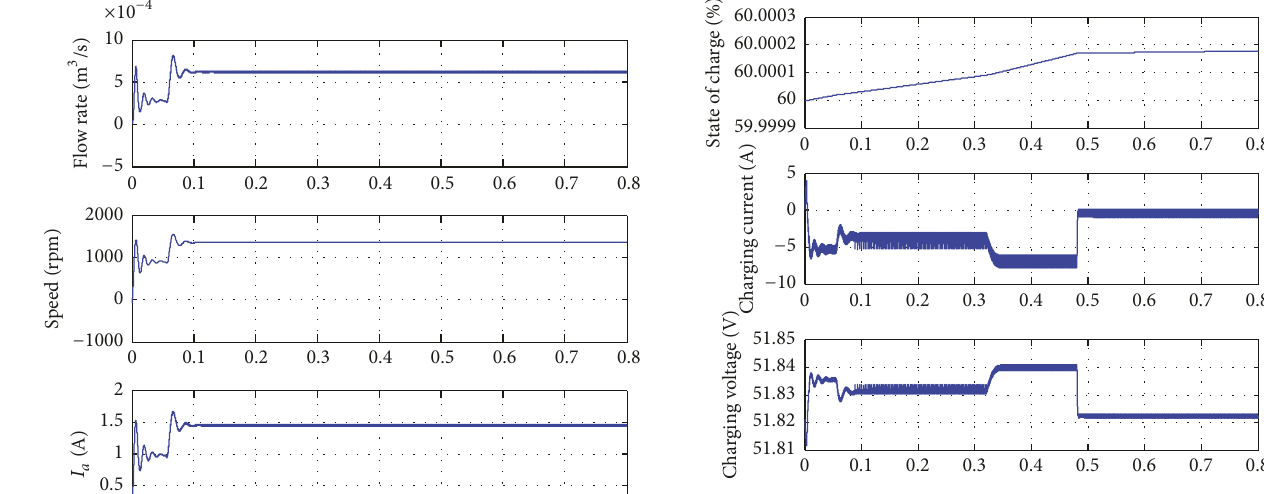
Figure 24: Battery state of charge at various solar irradiation